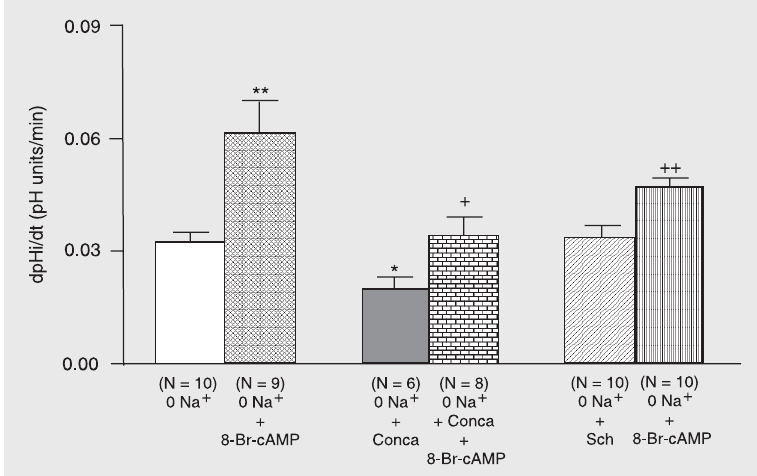
Figure 3. Effect of 10 µM 8-Br-cAMP, a membrane-permeant form of cAMP, on the mean initial rate of pHi recovery in C11 cells incubated in 0 Na + solution. Mean ± SEM dpHi/dt during superfusion with 0 Na + Ringer containing 10 µM 8-Br-cAMP, 46 nM concanamycin (Conca), an H + -ATPase blocker, and/or 50 µM Schering 28080 (Sch), an H + /K + -ATPase inhibitor. *P < 0.05 vs control (0 Na + ). **P < 0.01 vs 0 Na + . + P < 0.05 vs concanamycin. ++ P < 0.05 vs Sch 28080 (unpaired